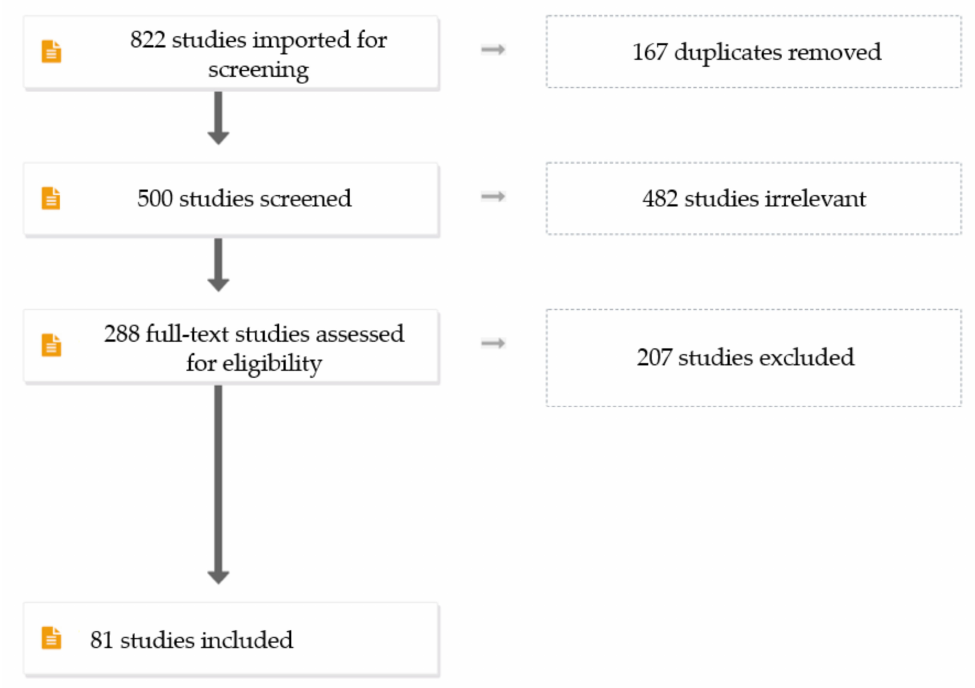
Figure 4. Flowchart showing publications selection